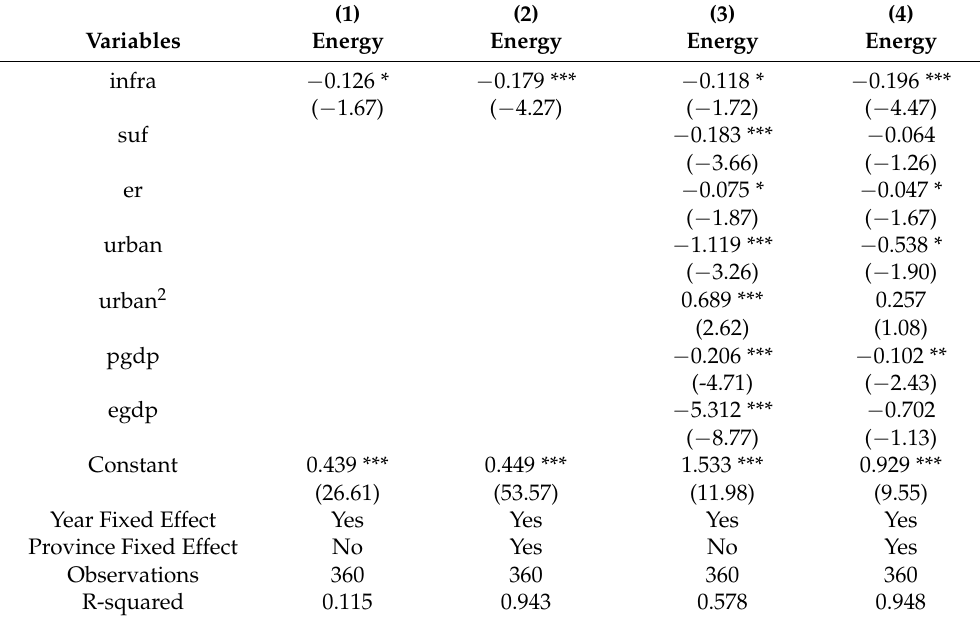
Table 4. Direct impact of NDI on energy structure